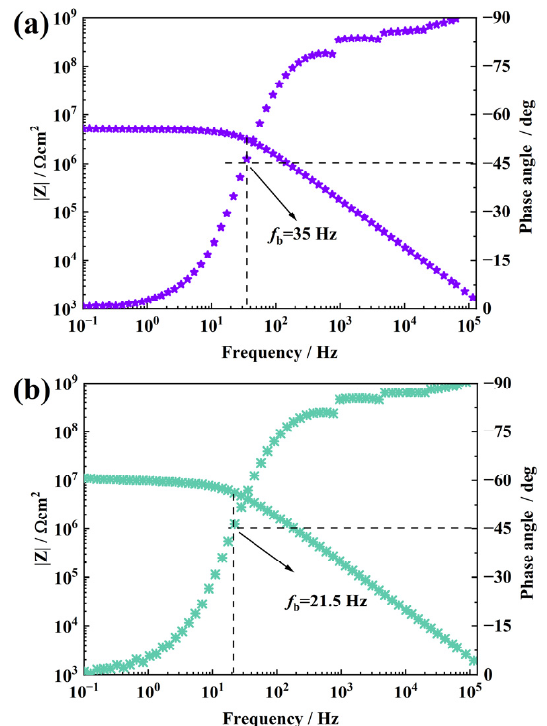
Figure 6. Bode plots of RTV coatings ( a ) and 0.1 wt.% f-GO/RTV nanocomposite coatings ( b ) after